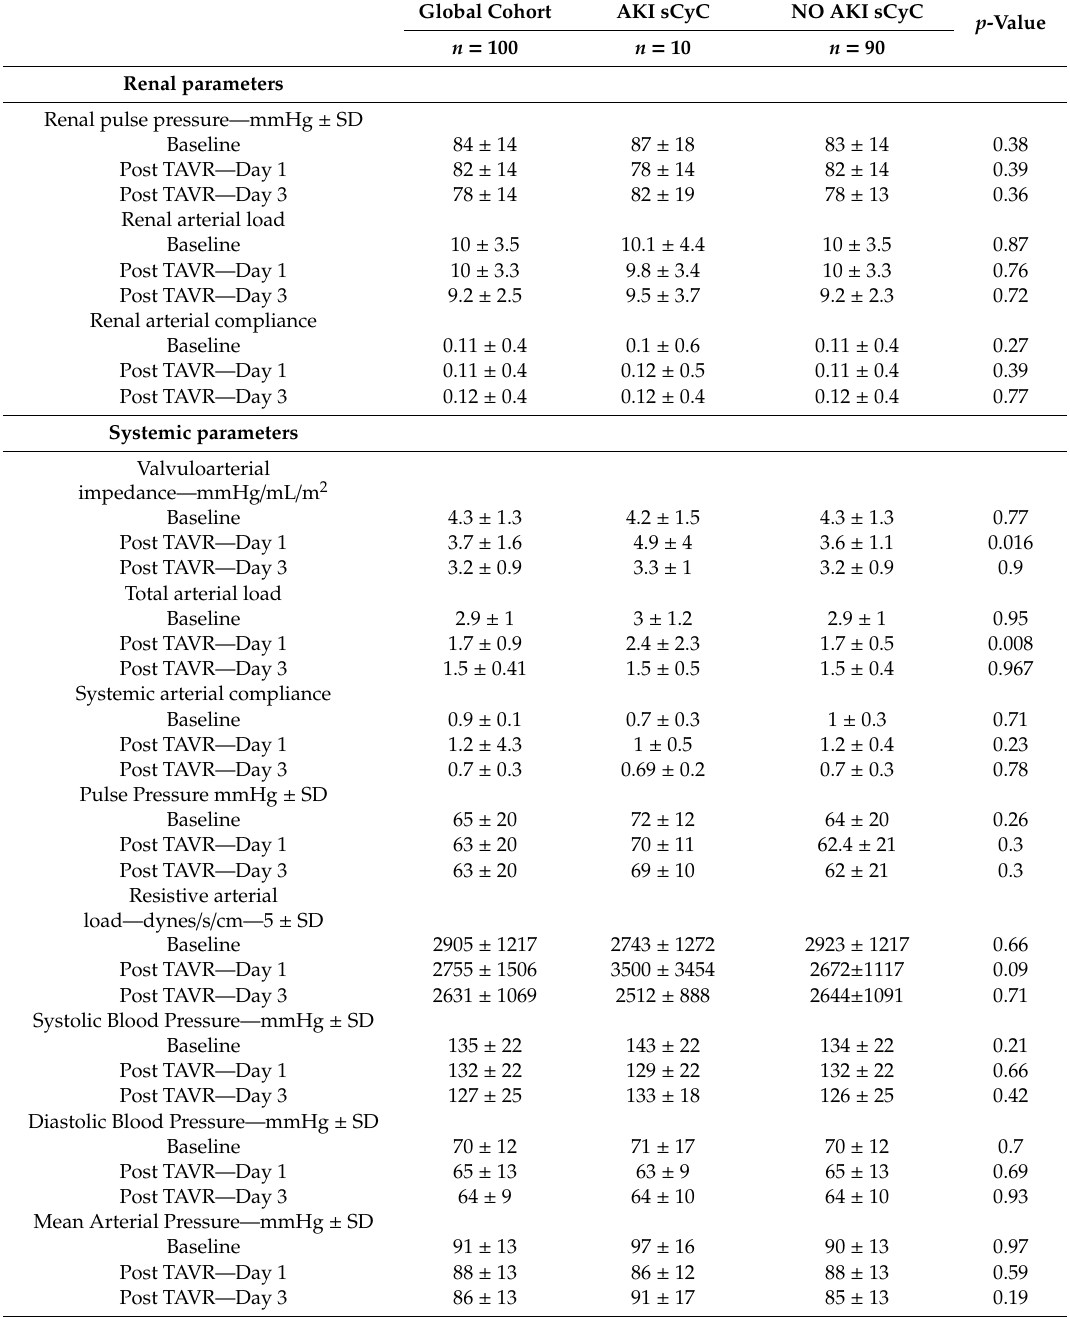
Table 7. Systemic and renal hemodynamic